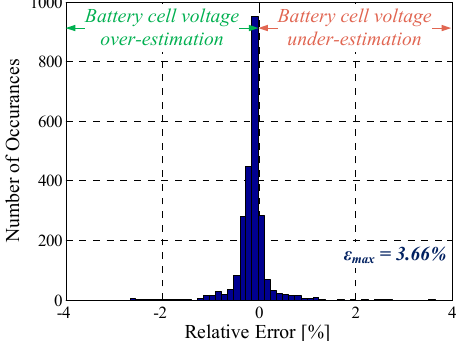
Figure 21. Distribution of the relative error obtained during pulse discharging verification case.